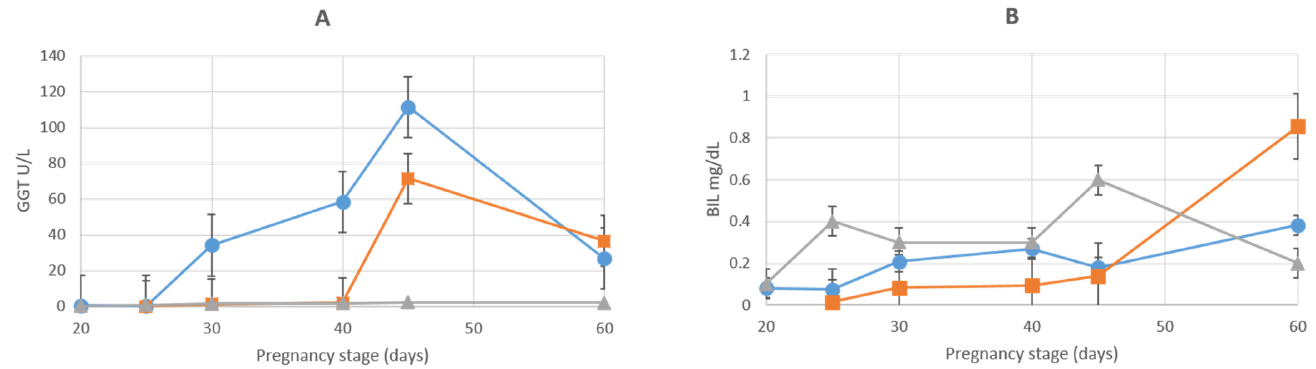
Figure 6. Graphic representation of GGT ( A ) and BIL ( B ) concentrations during pregnancy in maternal serum (marked with ▲ ), amniotic fl uid (marked with ● ) and allantoic fl uid (marked with ■ ). Values are indicated as mean ± SE.